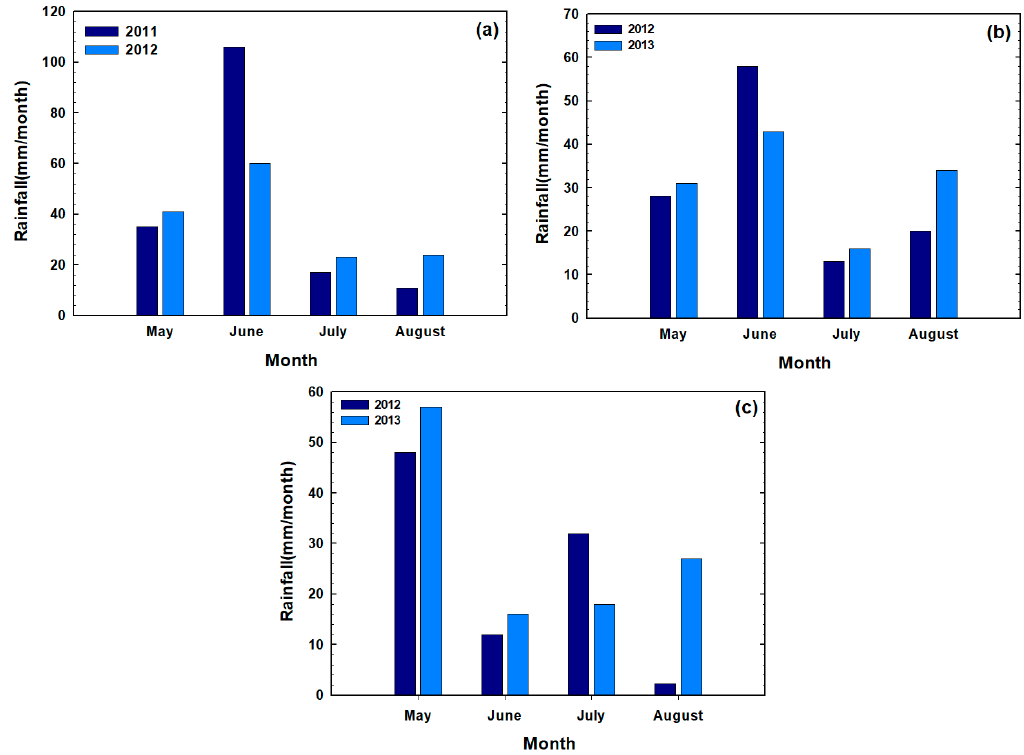
Figure 5. Monthly rainfall at Pondera ( a ), Chouteau ( b ), and Teton ( c ) during growing season.